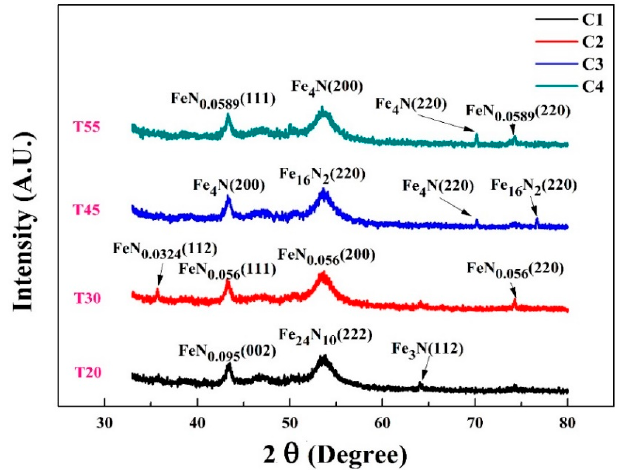
Figure 4. The XRD pattern for iron nitride films grown at different deposition time spans.